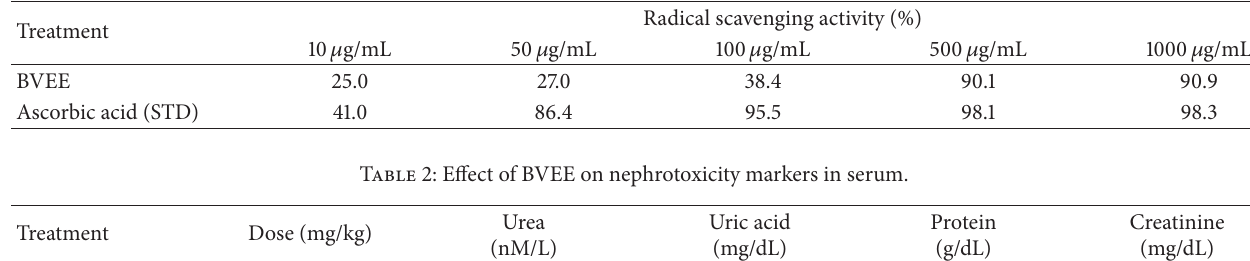
Table 1: Free radical-scavenging activity of the BVEE, fractions, and ascorbic acid (DPPH-assay).